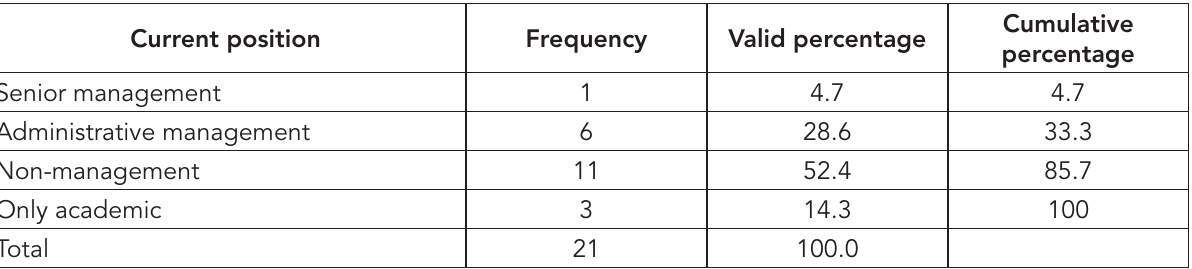
Table 1: Current position within the department